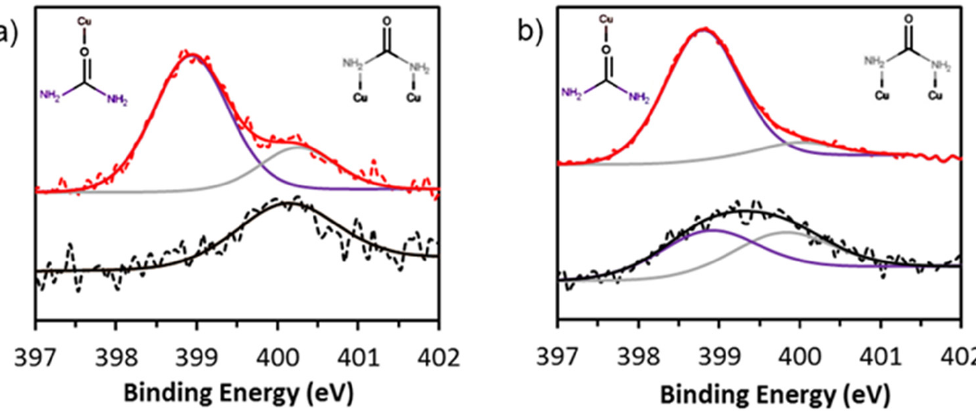
Figure 12. Nitrogen 1s peak of ( a ) CF-18H-100U and ( b ) CF-18H-DCU, before electrolysis (bottom black signal) and post 35 min electrolysis (top red signal). The hypothesized integration of urea with the copper foam is depicted at the top of the figure and color-coded with XPS fittings.